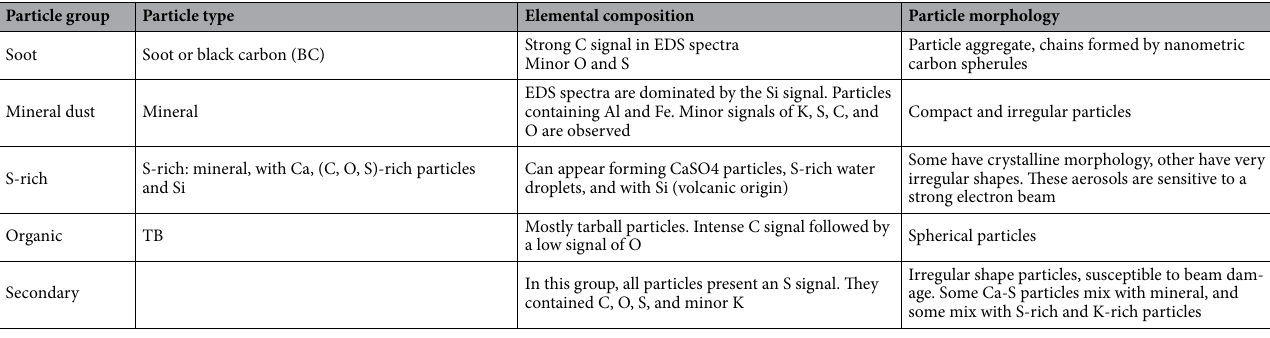
Table 2. Aerosol groups observed at the